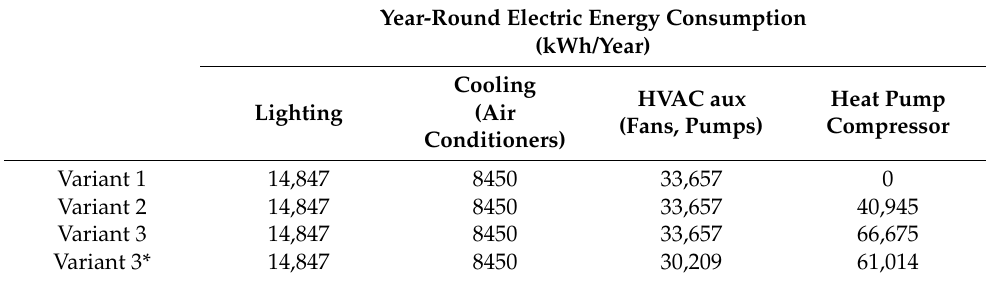
Table 1. Year-round electric energy consumption in the building for all calculation variants.